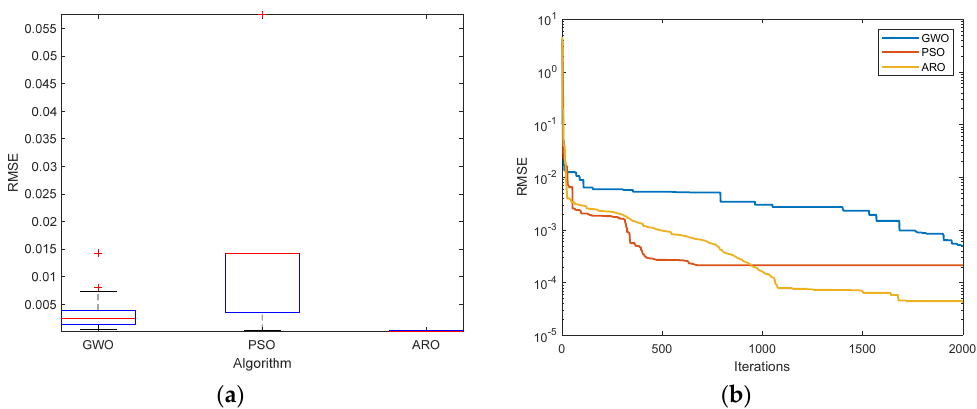
Figure 13. Boxplot and convergence graphs of various algorithms: ( a ) boxplot; and ( b ) convergence graph. Table 6. Identification results of various algorithms for 5 kW cell stack